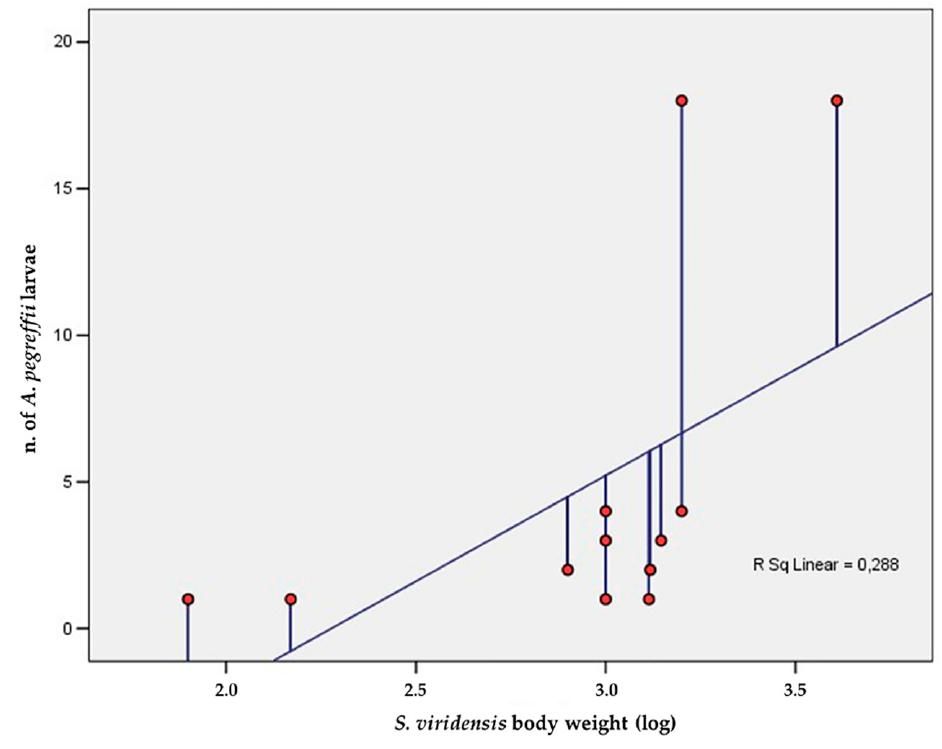
Figure 1. Correlation between Anisakis pegreffii larvae load and logarithm of S. viridensis body weight. The larvae were found mainly attached to the serous walls of the celomic organs and within the stomach and intestine walls. In one case, a large female specimen of 4064 g, a massive larvae infection was associated with nodular lesions on the gastric wall, showing the presence of viable larvae inside (Figure 2a,b). both sub-serosa and sub-mucosa (Figure 3). Frequently, parasitic bodies were surrounded by a thick granulomatous reaction, made up of macrophages, epithelioid cells, some lymphocytes and an external connective sheet, although singular parasites appeared to be simply encysted within a thin fibrous reactive